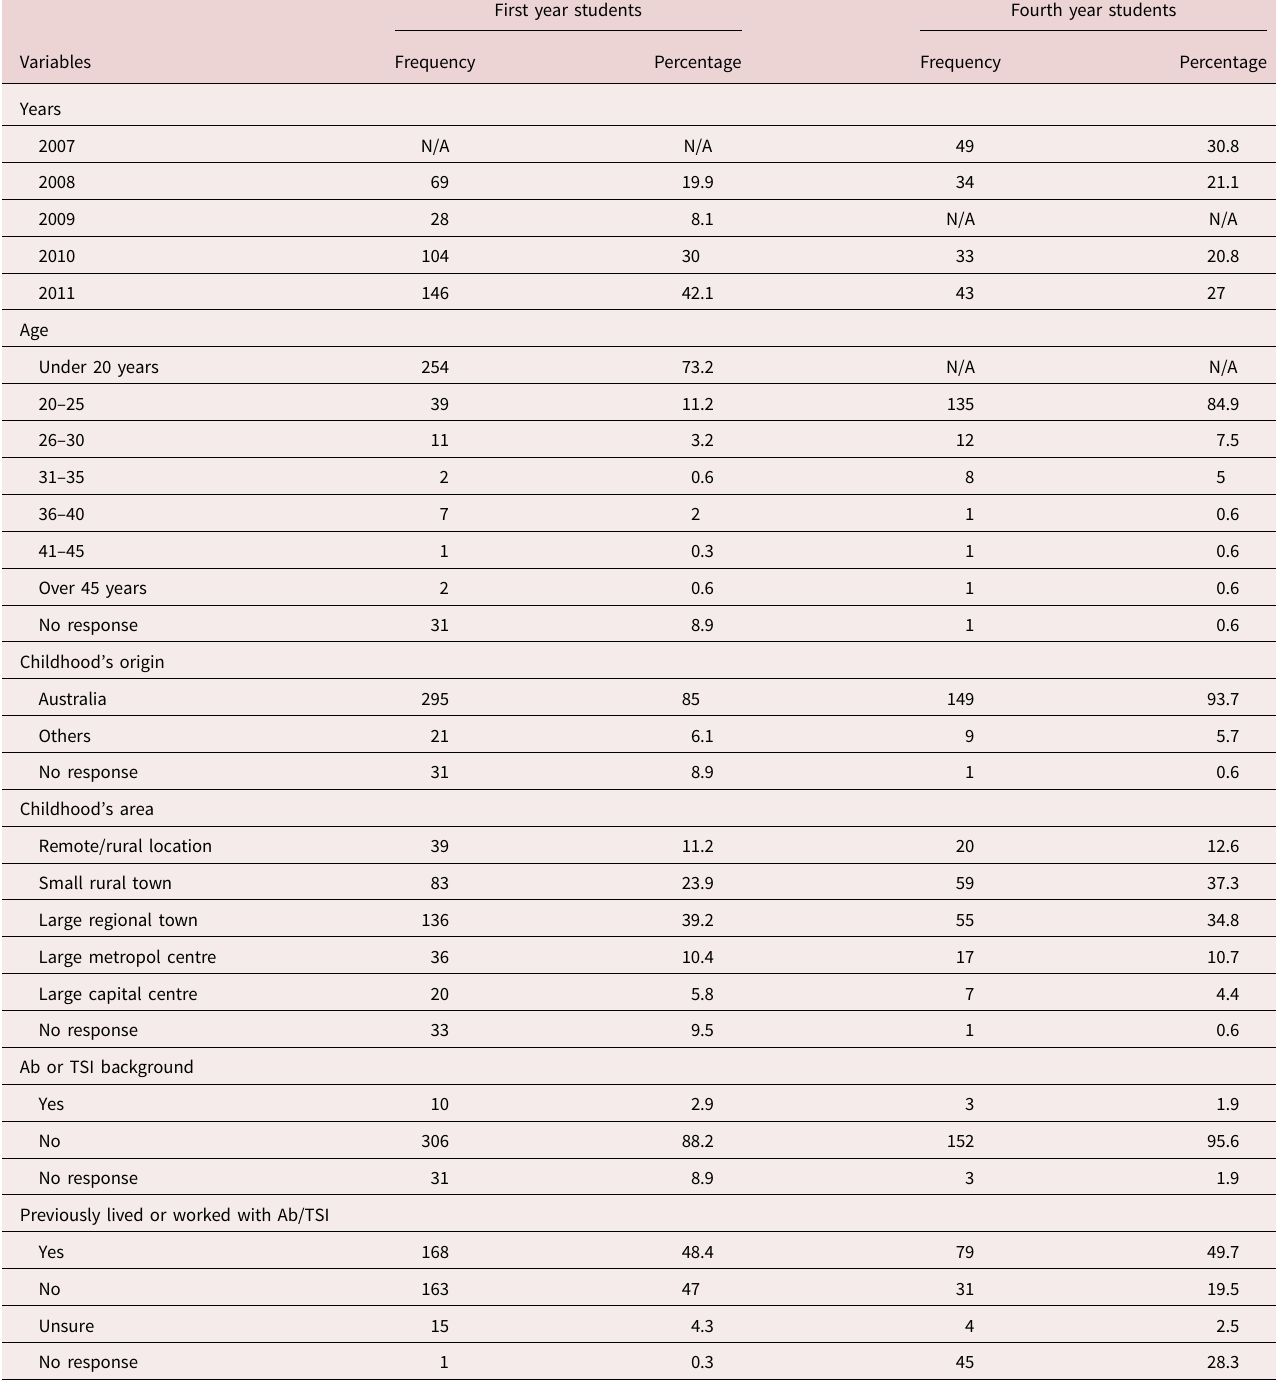
Table 2. Characteristics of the student participating in this